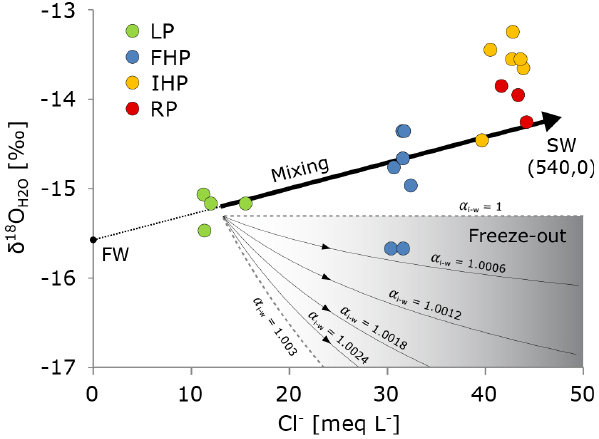
Figure 11. Cl − concentration and δ 18 O H of pingo spring water 2 O samples. The thick black model line is drawn by assuming that the LP samples result from the mixing of seawater and a freshwater endmember with a zero Cl − concentration. The range of possible δ 18 O H values following freeze-out (Eq. 8) from water with an 2 O initial composition similar to LP is illustrated with the shaded area. Here, Cl − is assumed to be completely excluded from the ice. The lower and upper edges of the shading represent equilibrium frac- tionation and no fractionation, respectively, while the intermediate model lines illustrate fractionation at 20%, 40%, 60% and 80% (top–bottom) of equilibrium